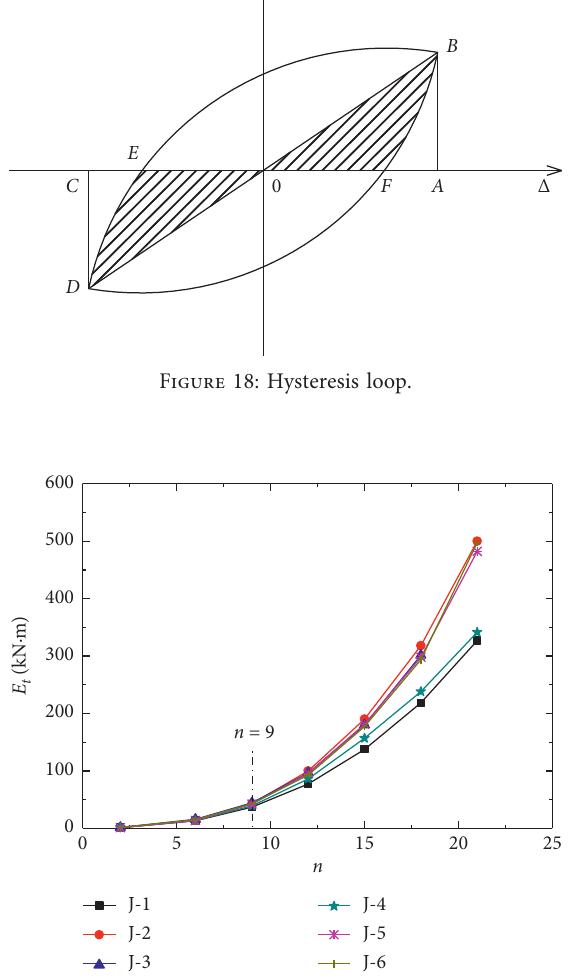
Figure 19: Accumulated energy